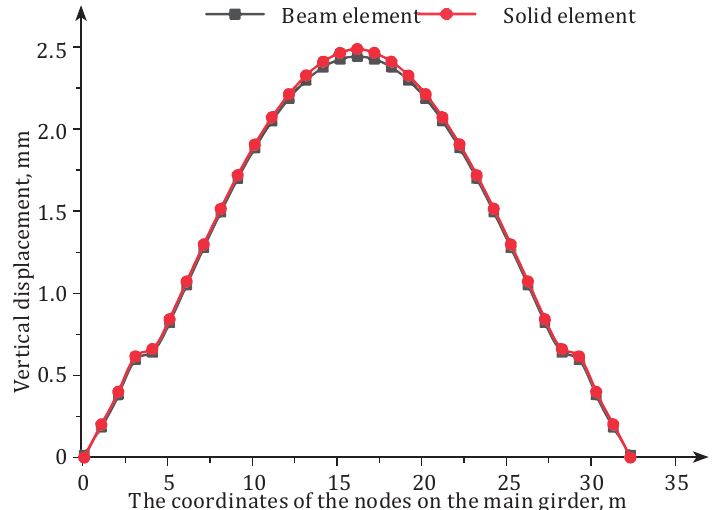
Figure 5. Comparison of static displacement between two models